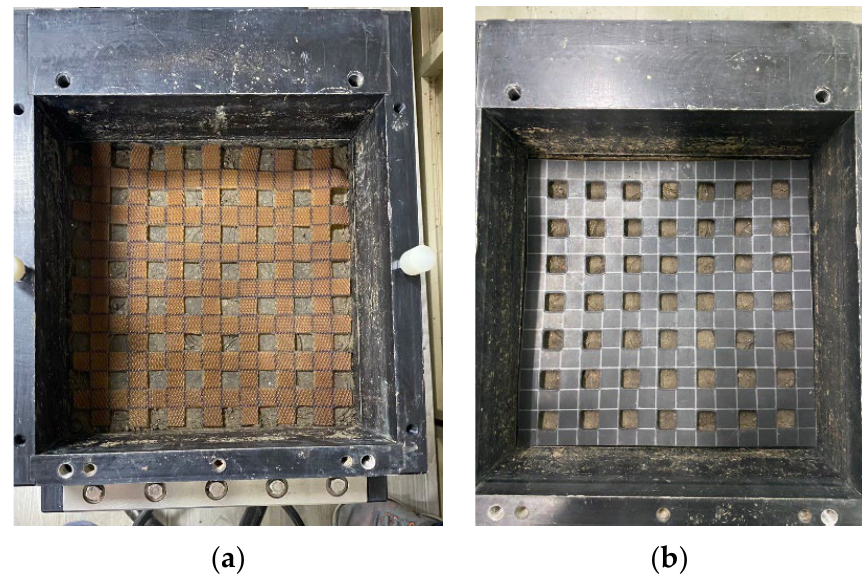
Figure 5. The RSS and RCS geogrids in the shear box: ( a ) RSS geogrid; ( b ) RCS geogrid.